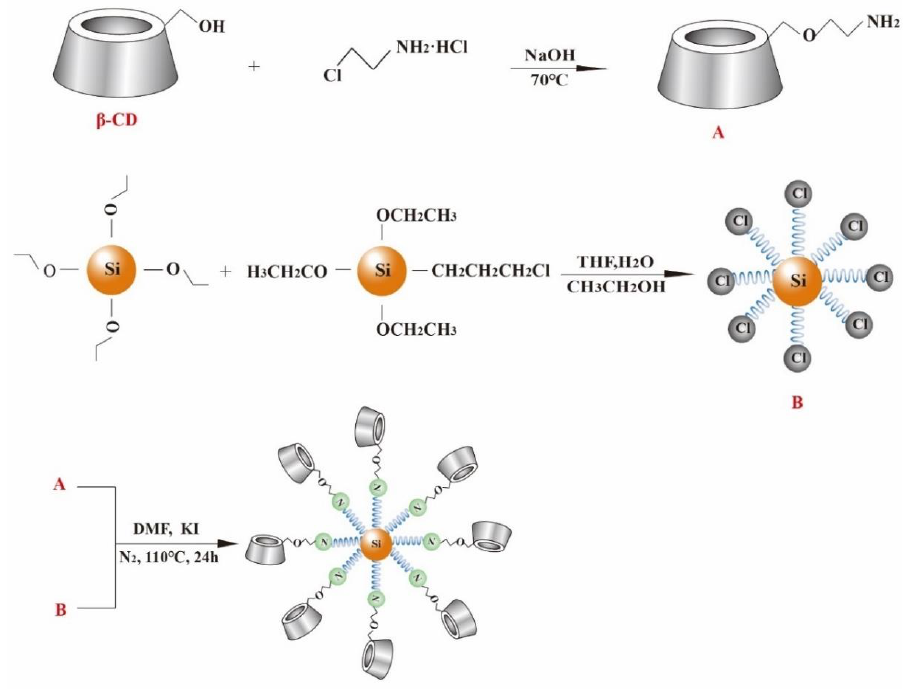
Scheme 1. Schematic representation of the preparation steps of 6-EA-β-CD-Si.